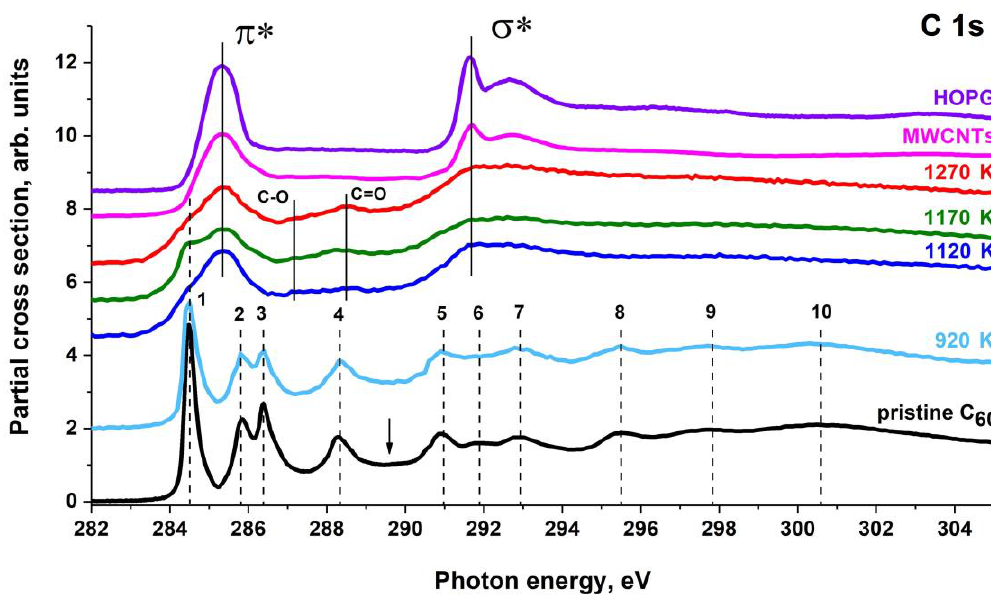
Figure 4. C 1s NEXAFS spectra of the HOPG, MWCNTs, pristine and HIP-treated at different temperatures fullerite C 60 . The arrow indicates the position of the fullerite C 60 C 1s absorption edge (289.60 eV) [42]. The HOPG spectrum was obtained at the 40° grazing incidence angle of a linearly polarized SR beam on the sample surface.